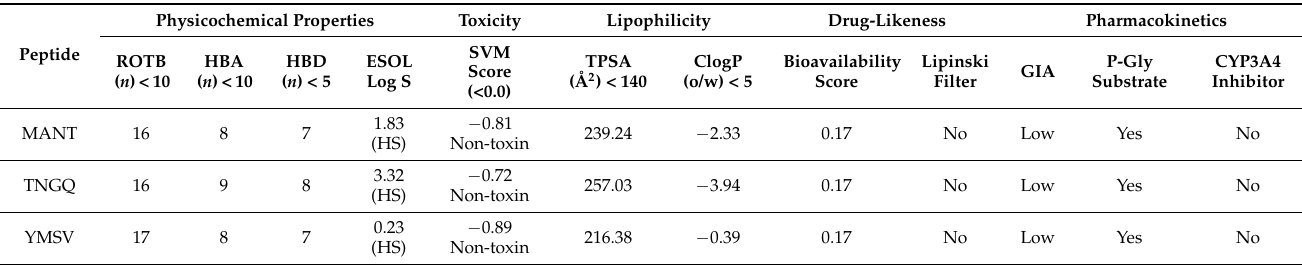
Table 2. Absorption, distribution, metabolism, excretion, and toxicity (ADME/Tox) profile for tetrapeptides MANT, TNGQ, and YMSV to predict drug-likeness and suitability for human